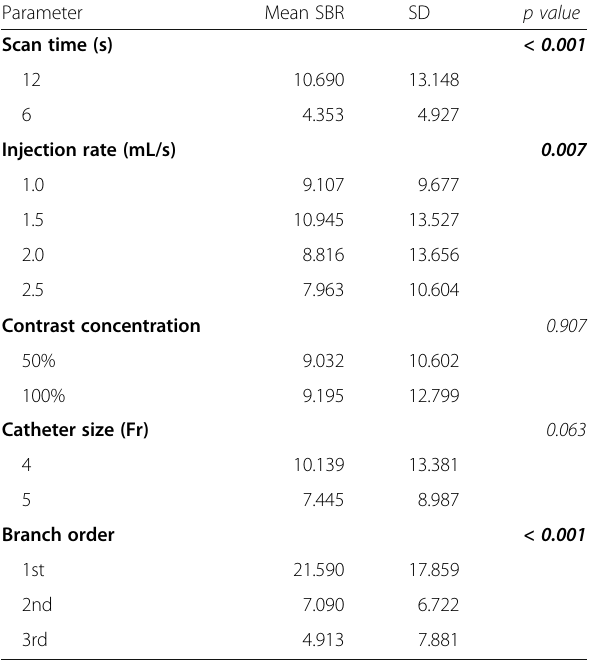
Table 2 Mean sideband ratio (SBR) value and standard deviation (SD) for different parameters that were investigated Parameter